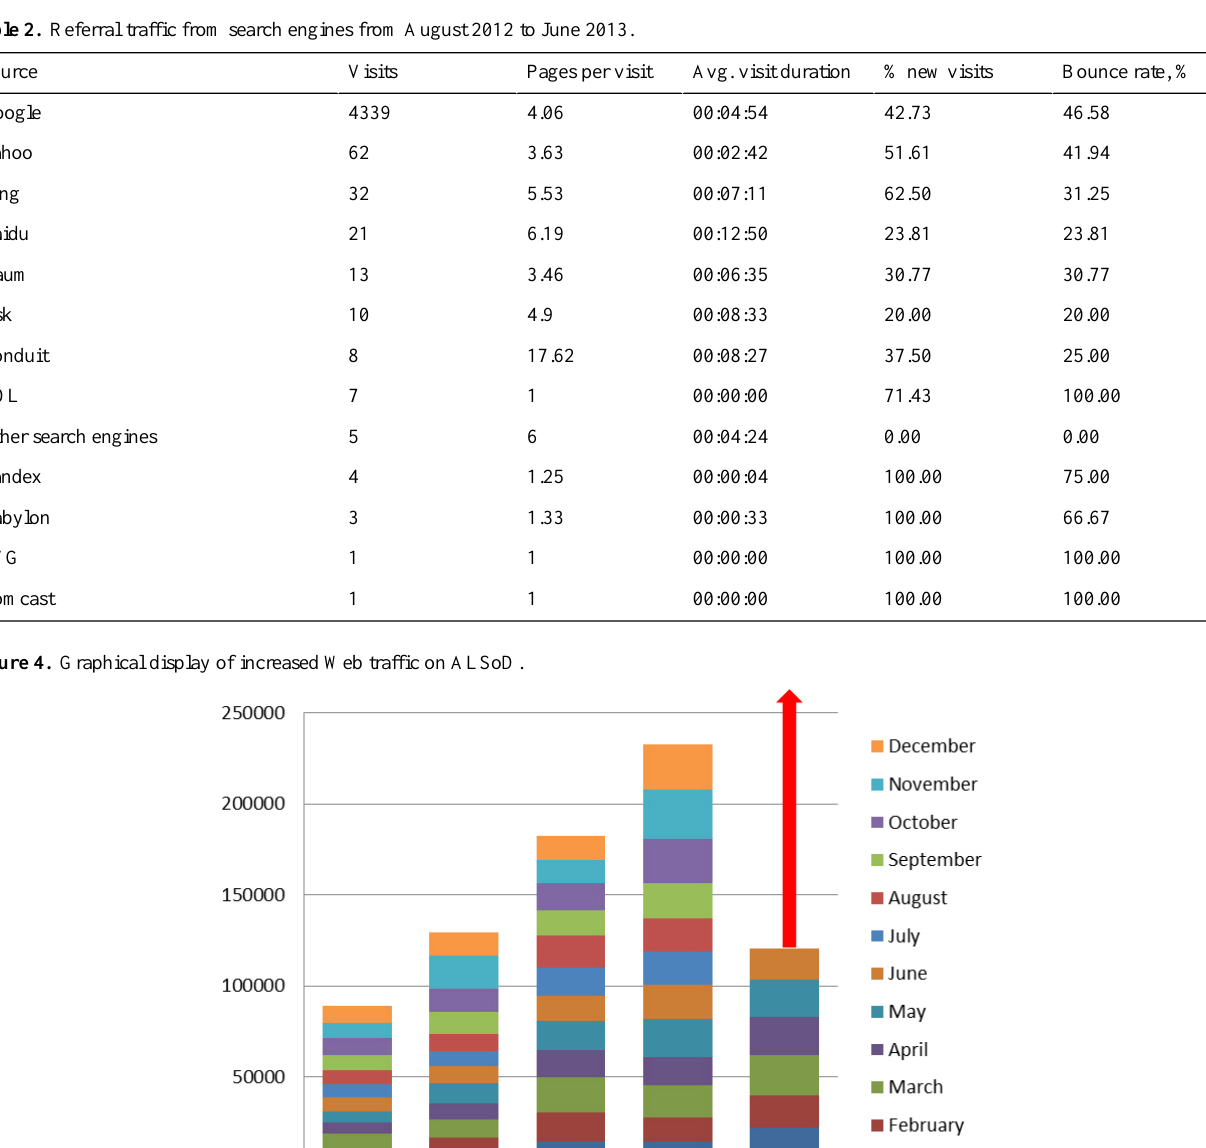
Table 2. Referral traffic from search engines from August 2012 to June 2013.